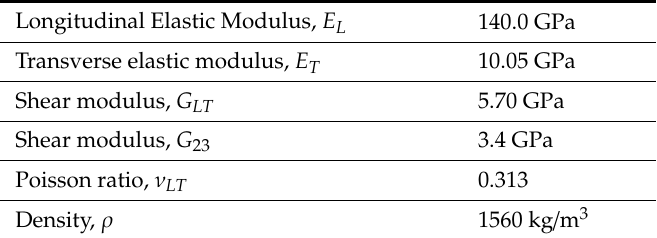
Table 2. Properties of CFRP T300/914 composites.